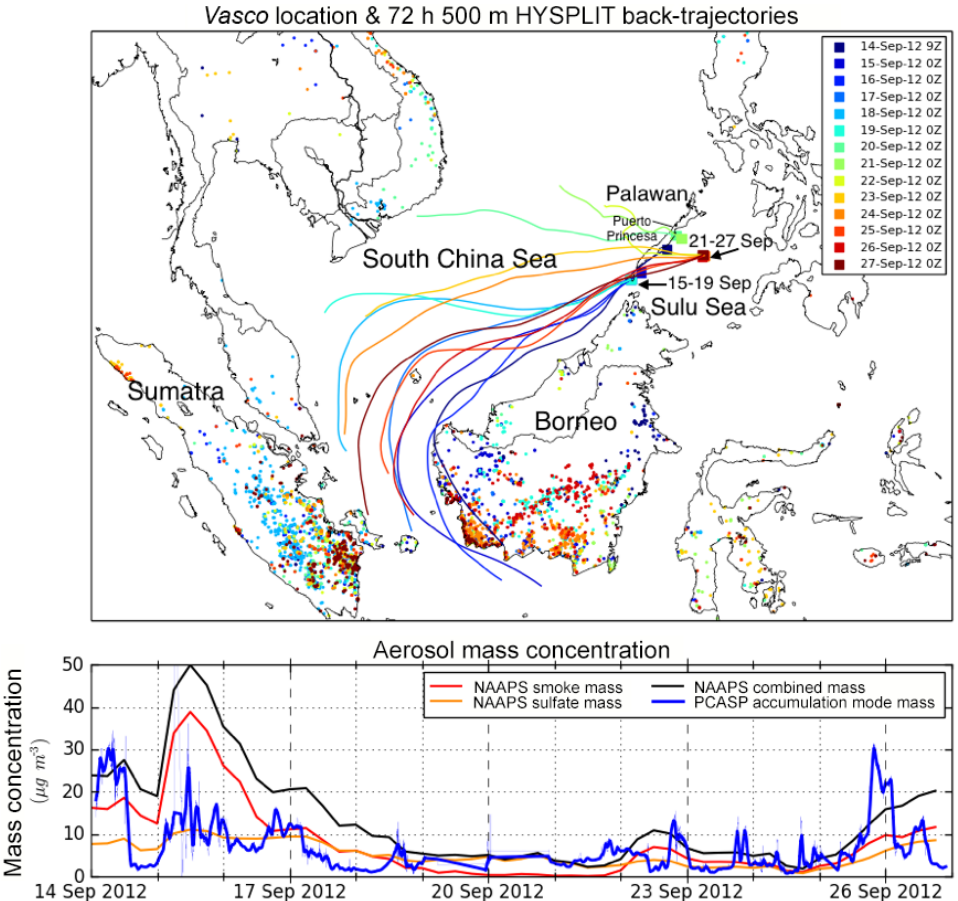
Figure 1. (a) Vasco cruise locations (squares) and 72h, 500m HYSPLIT back-trajectories; MODIS fire detections (dots) from Terra and Aqua are included for each day (color coded) during the sampling period. (b) PCASP reconstructed accumulation mode (125–800nm) mass concentration (assumed density 1.4µgm − 3 ) and NAAPS-estimated smoke and sulfate mass concentration along the Vasco ship